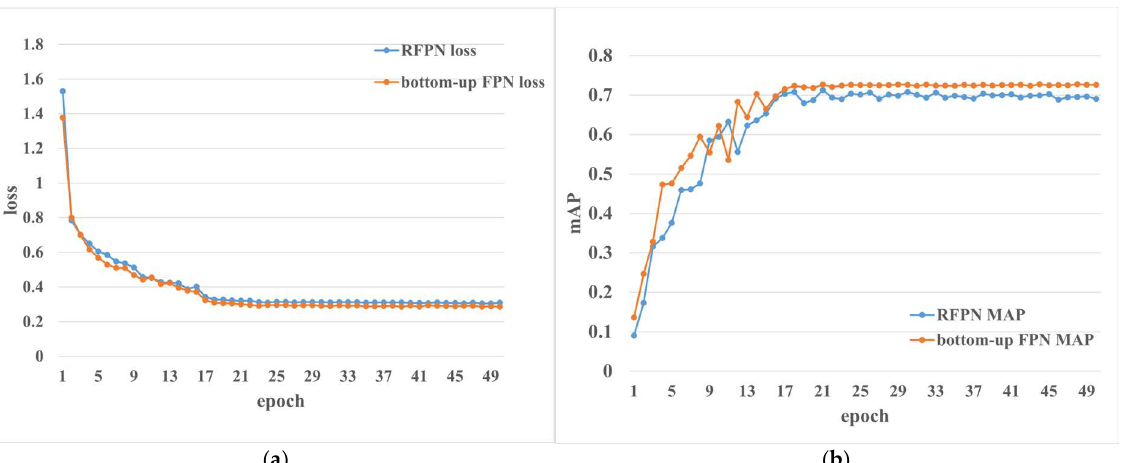
Figure 12. Loss curves and mAP curves after adding improved FPN module. ( a ) Loss of the models with different FPN modules. ( b ) mAP of the models with different FPN modules.